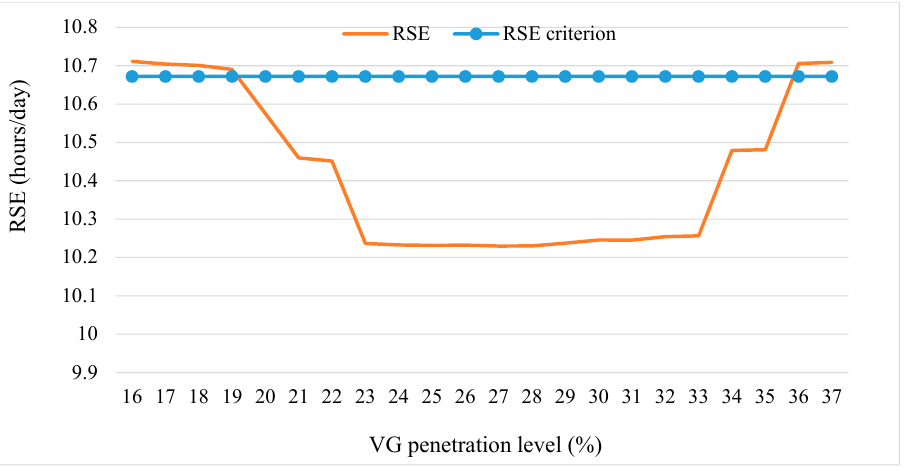
Figure 6. RSE versus VG penetration level.